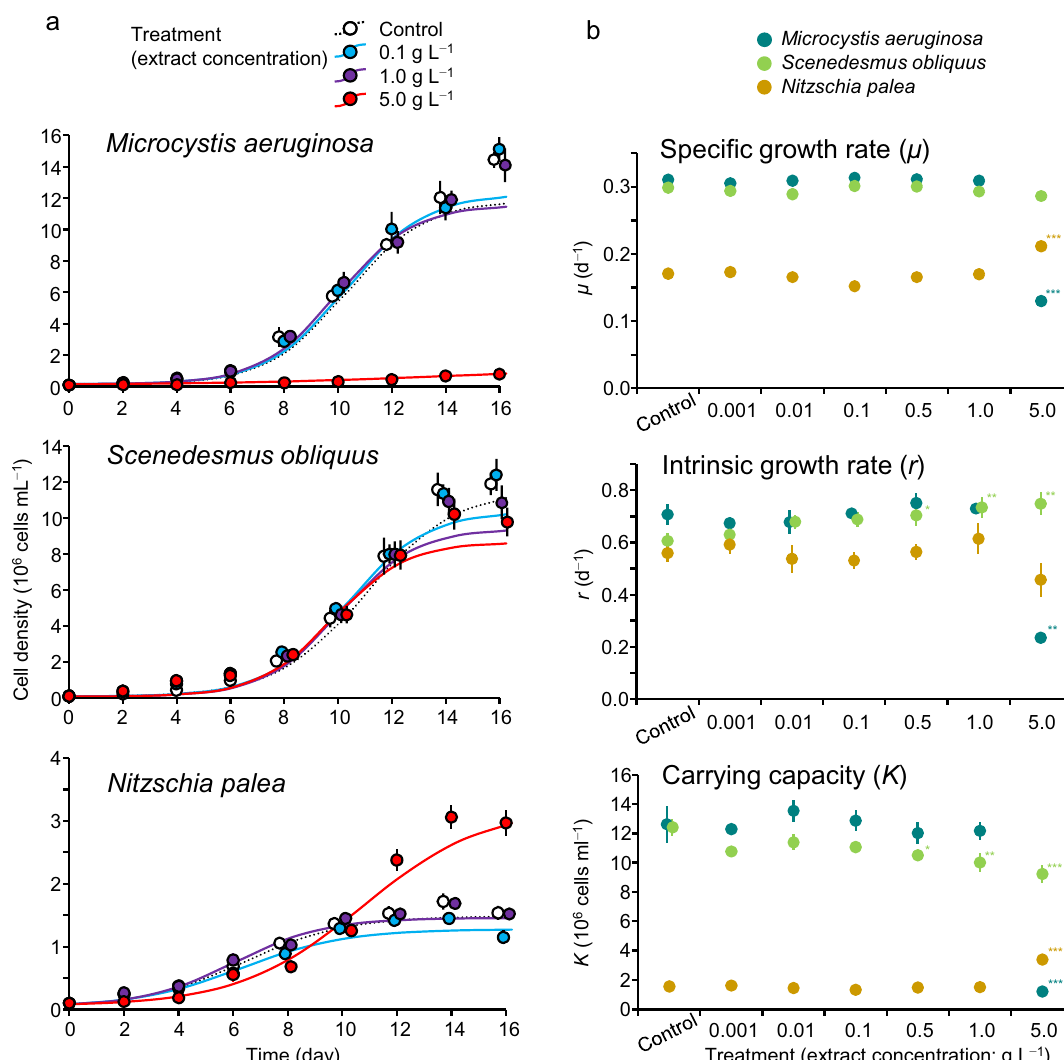
Figure 1. Growth pattern ( a ) and growth parameters ( b ) of each algal species in different treatments in the mono-culture system (the control and selected three treatments are shown in a ). Each growth curve was fitted with a logistic model. Error bars are SD ( n = 3). Asterisks denote a significant difference between the control and extract treatments (Dunnett’s test, * : p < 0.05, ** : p < 0.01, *** : p <